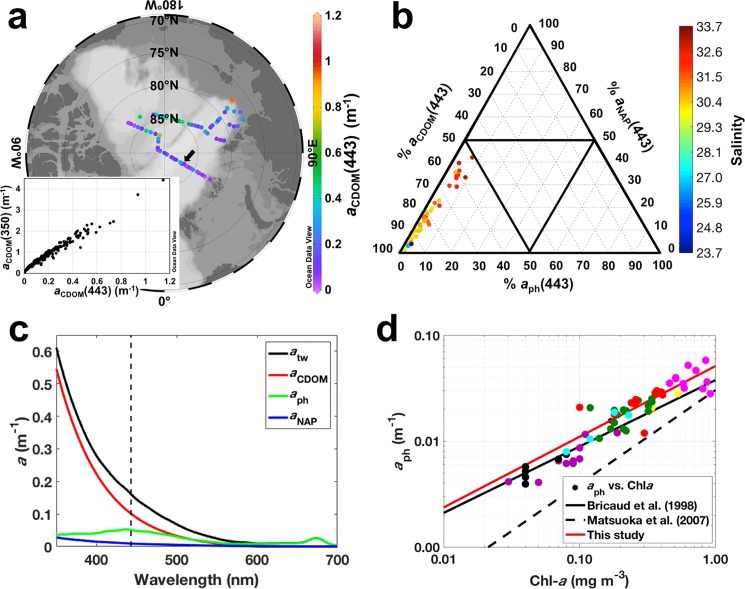
Absorption coefficients in the surface waters of central and eastern Arctic Ocean.(a) Surface distribution of aCDOM(443) (m-1) and correlation between aCDOM(443) and aCDOM(350) (inset graph); produced with Ocean Data View [44]. (b) Ternary plot denoting the contribution of the non-water absorbers [aCDOM(443), aph(443), aNAP(443)] to total non-water absorption [atw(443)] at surface; color bar indicates salinity. (c) Station 207 (indicated by the arrow in a) as example of atw(λ), aCDOM(λ), aph(λ) and aNAP(λ) spectra (m-1). Dashed line indicates the position of 443 nm. (d) Correlation between Chl-a (mg m-3) and aph(443) (m-1); for the colors, please refer to Fig 4.